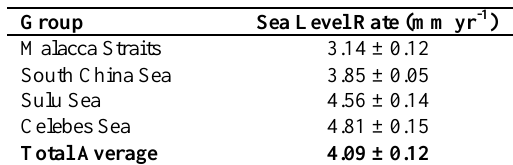
Table 4. Summary of the absolute sea level rate over